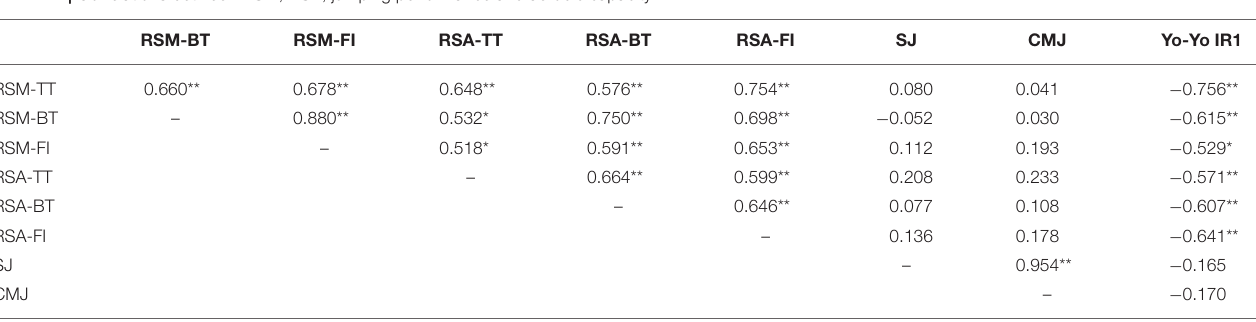
TABLE 4 | Correlations between RSM, RSA, jumping performance and aerobic capacity.